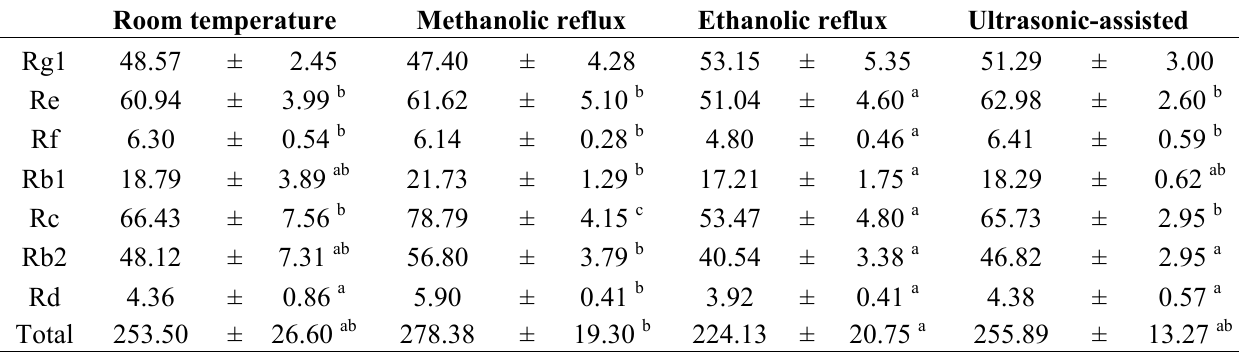
Table 1. Ginsenoside fingerprint profiles derived from different extraction methods expressed in mg/g. Rows with a different letter are significantly different ( P <